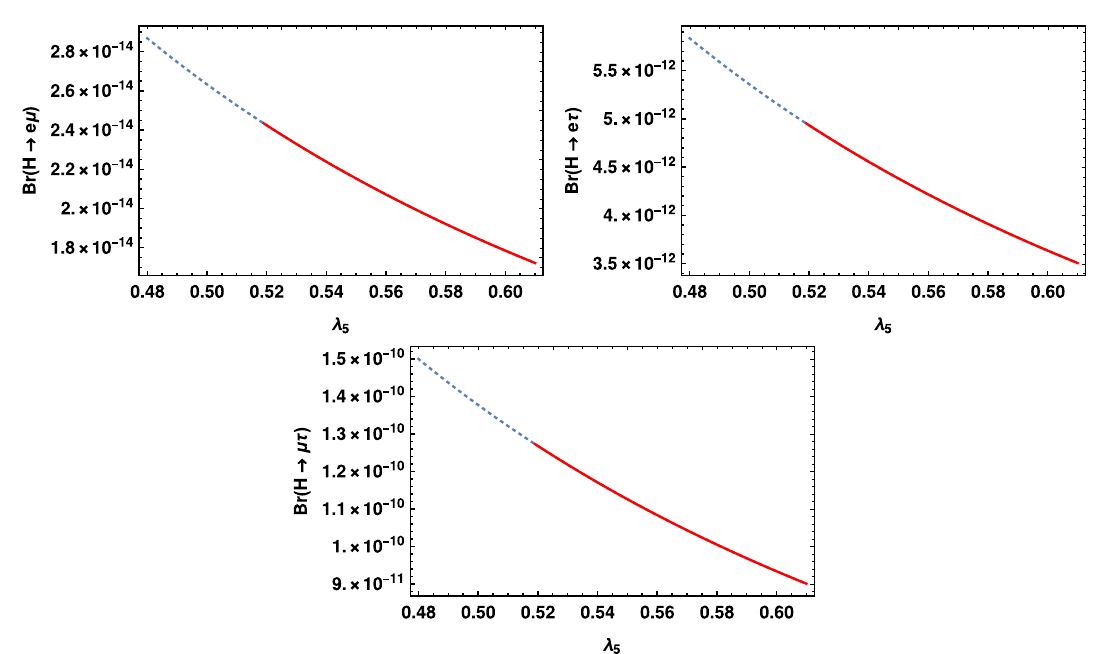
Fig. 8 Plots between Br ( H → (cid:2) α (cid:2) β ) and λ 5 for the case of IO, after applying the constraints from Br ((cid:2) α → (cid:2) β γ) . In these plots, solid lines are allowed and dotted lines are excluded by the constraints due to